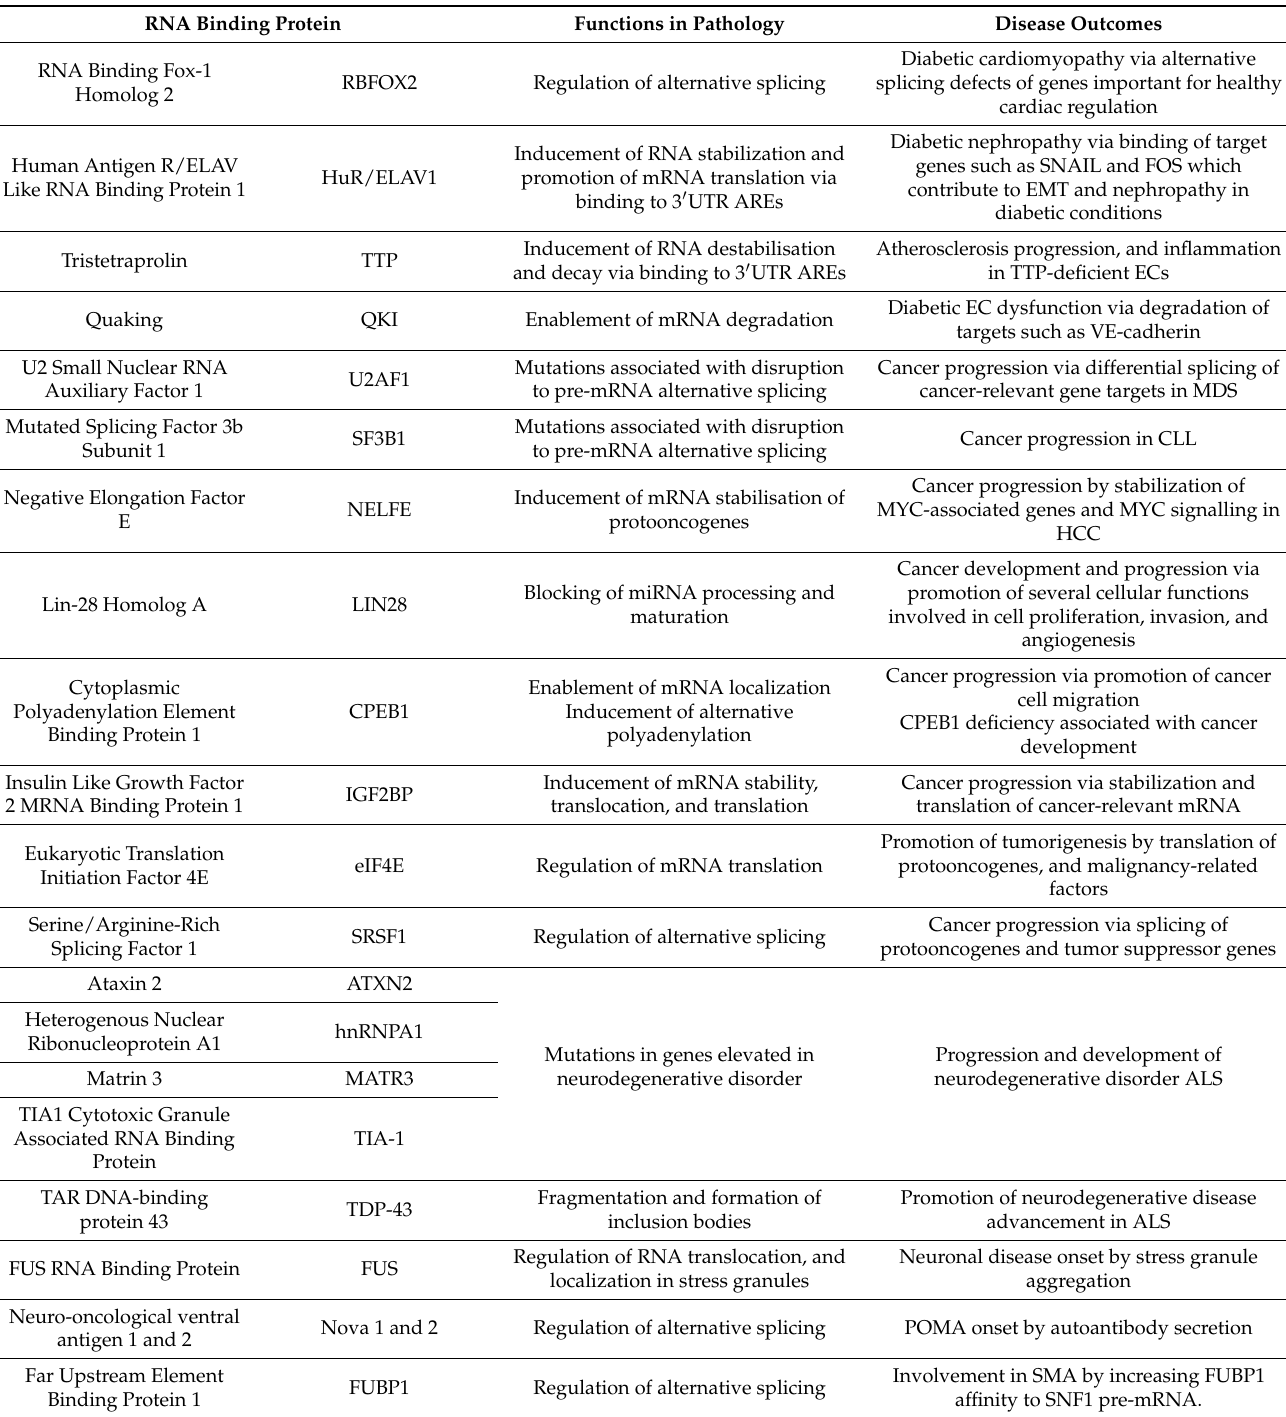
Table 1. Table displaying disorders arising from RNA-binding protein (RBP) dysfunction. Dysregulation of RBPs can lead to diseases such as cardiovascular and peripheral vascular disease, diabetes, cancer, and neurodegenerative